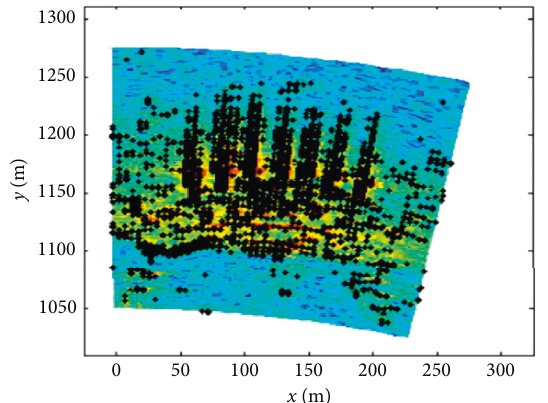
Figure 6: PS points extracted using the D are PSs).